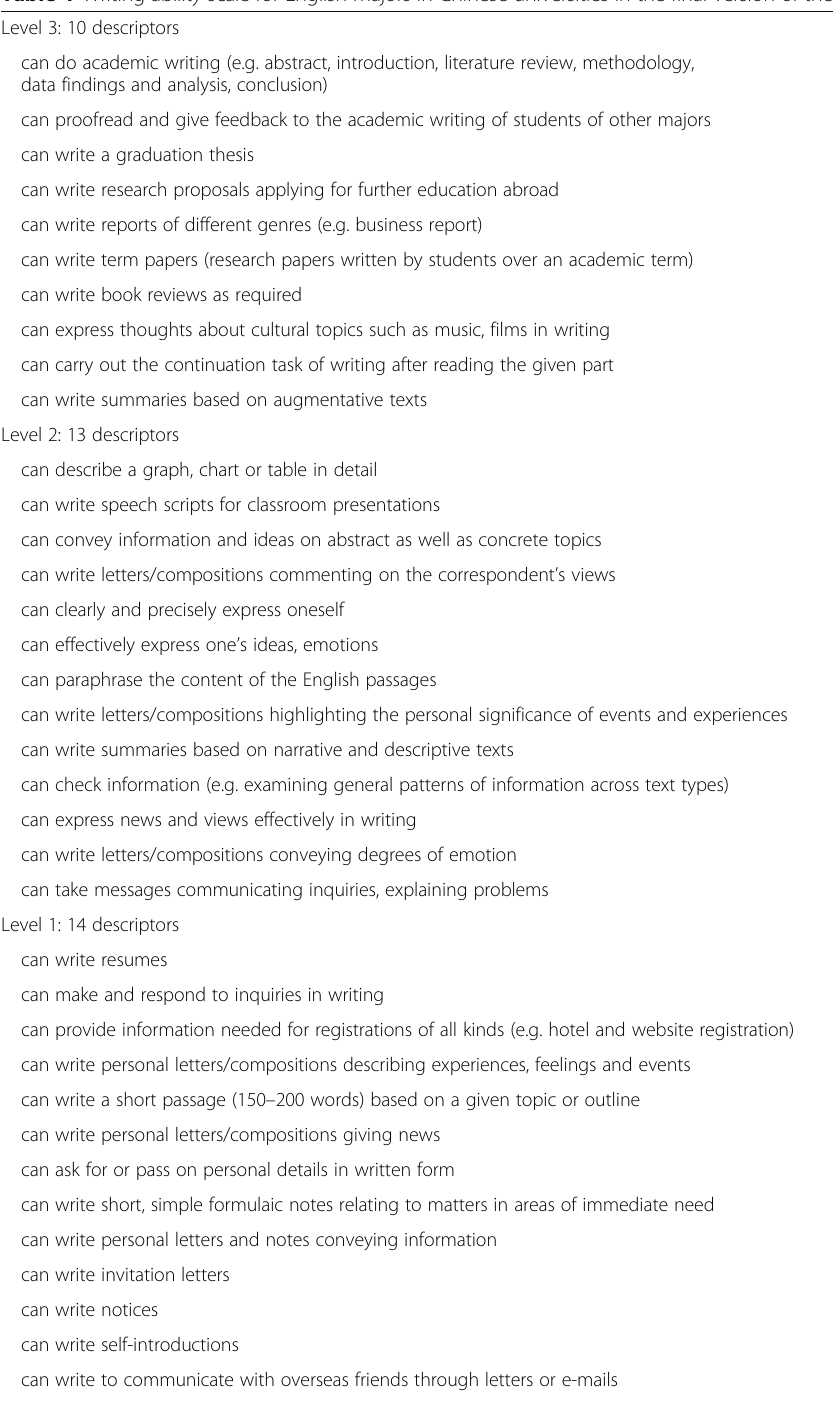
Table 1 Writing ability scale for English majors in Chinese universities in the final version of the writing Level 3: 10